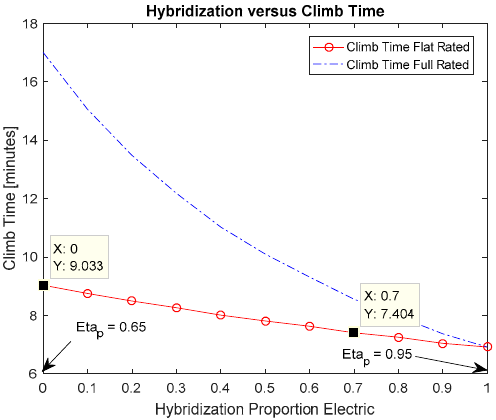
Figure 13. Time to climb vs. hybrid proportion at significantly improved propeller efficiency.